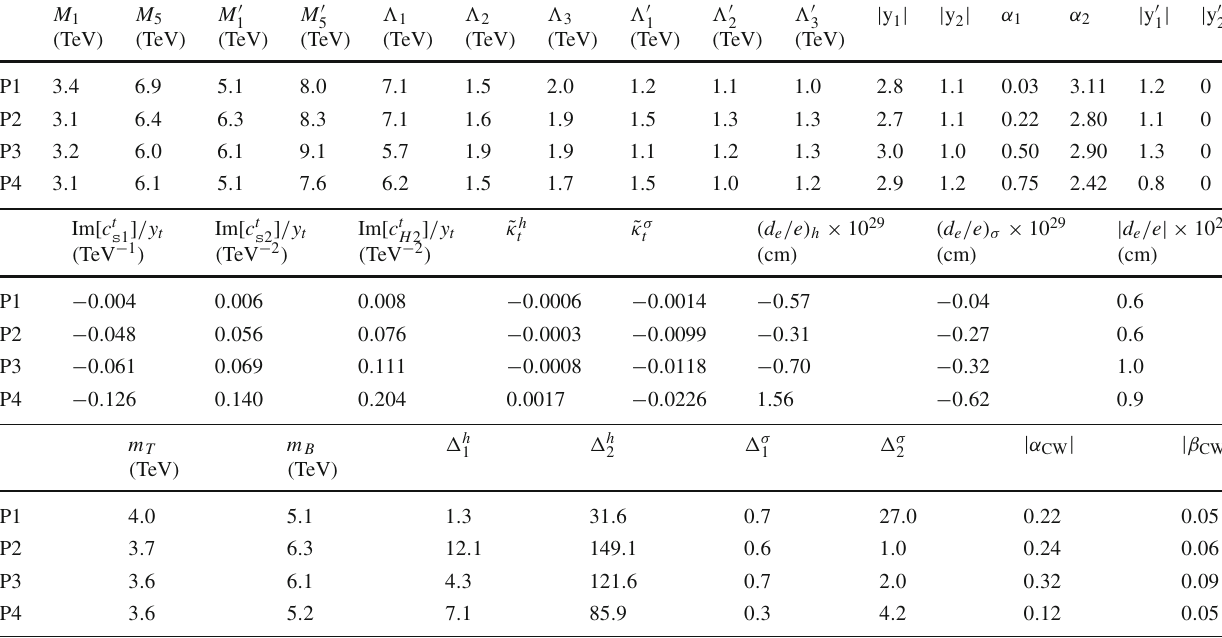
the middle panel, together with the respective Higgs and singlet contri- butions to the later. In the lower panel are shown the resulting lightest T and B quark partner masses, the (cid:13) h ,σ that quantify the amount of 1 , 2 tuning in the ML σ M CPV phases and the | α CW | and | β CW | parameters calculated from the Coleman-Weinberg